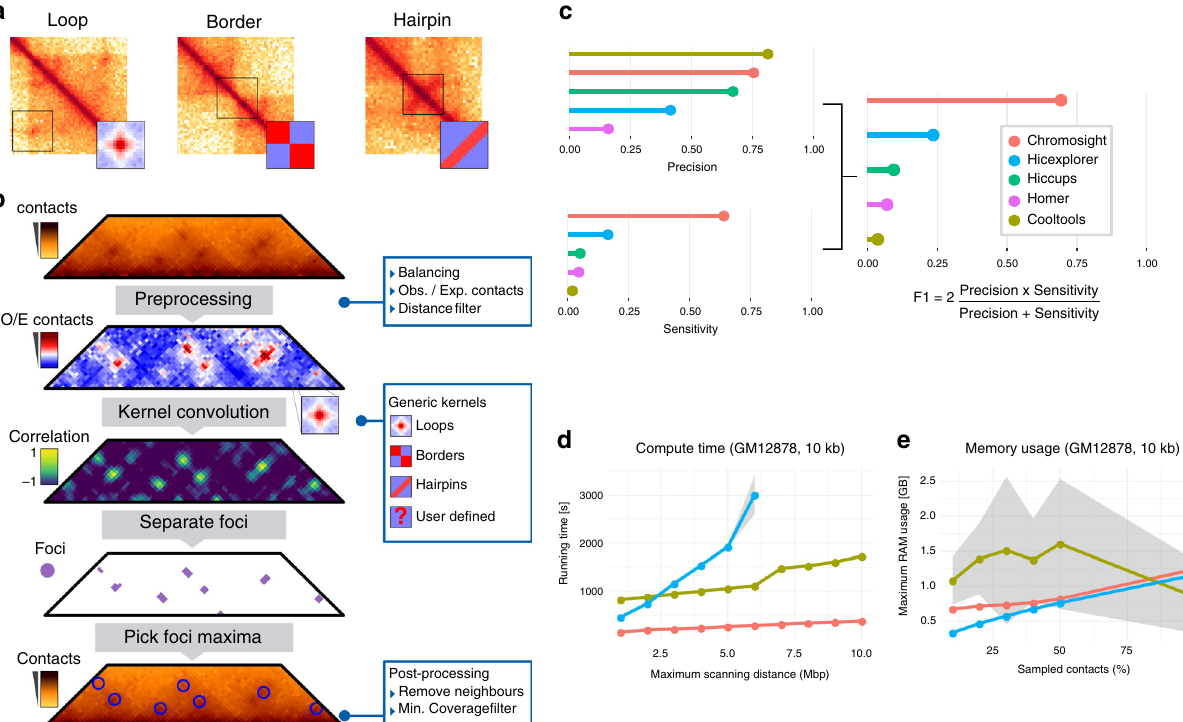
Fig. 1 Chromosight work fl ow and benchmark. a Examples of distinct patterns visible on contact maps (loop, border and hairpin) and the corresponding chromosight kernels. b Matrix preprocessing involves normalisation balancing followed by the computation of observed/expected contacts. Only contacts between bins separated by a user-de fi ned maximum distance are considered. The preprocessed matrix is then convolved with a kernel representing the pattern of interest. For each pixel of the matrix, a Pearson correlation coef fi cient is computed between the kernel and the surrounding window. A threshold is applied on the coef fi cients and a connected component labelling algorithm is used to separate groups of pixels (i.e. foci) with high correlation values. For each focus, the coordinates with the highest correlation value are used as the pattern coordinates. Coordinates located in poorly covered regions are discarded. c Comparison of Chromosight with different loop callers. Top: F1 score, Precision and Sensitivity scores assessed on labelled synthetic Hi – C data. Higher is better. d Run-time. e Memory usage according to maximum scanning distance and the amount of subsampled contact events, respectively. Means and standard deviations (grey areas) are